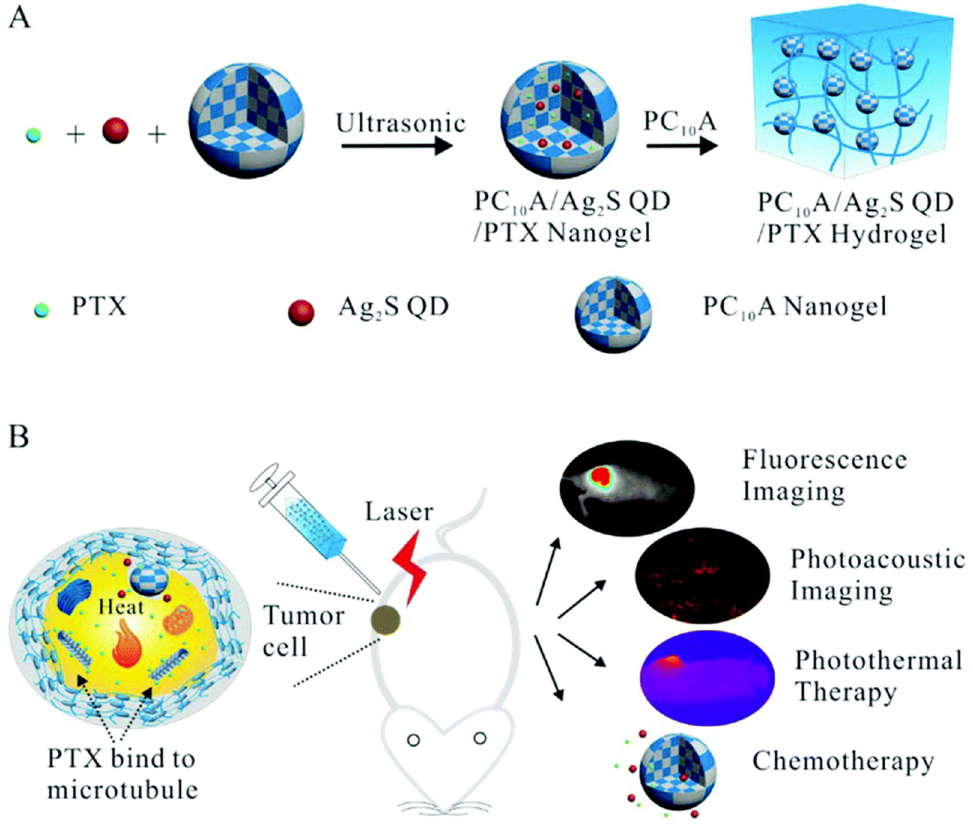
Figure 10. ( A ) Schematic illustration of the preparation of the injectable multifunctional PC 10 A hydrogel and ( B ) its application for combinational antitumor PTT-chemotherapy. Reproduced from Ref. [233] with permission from the Royal Society of Chemistry.